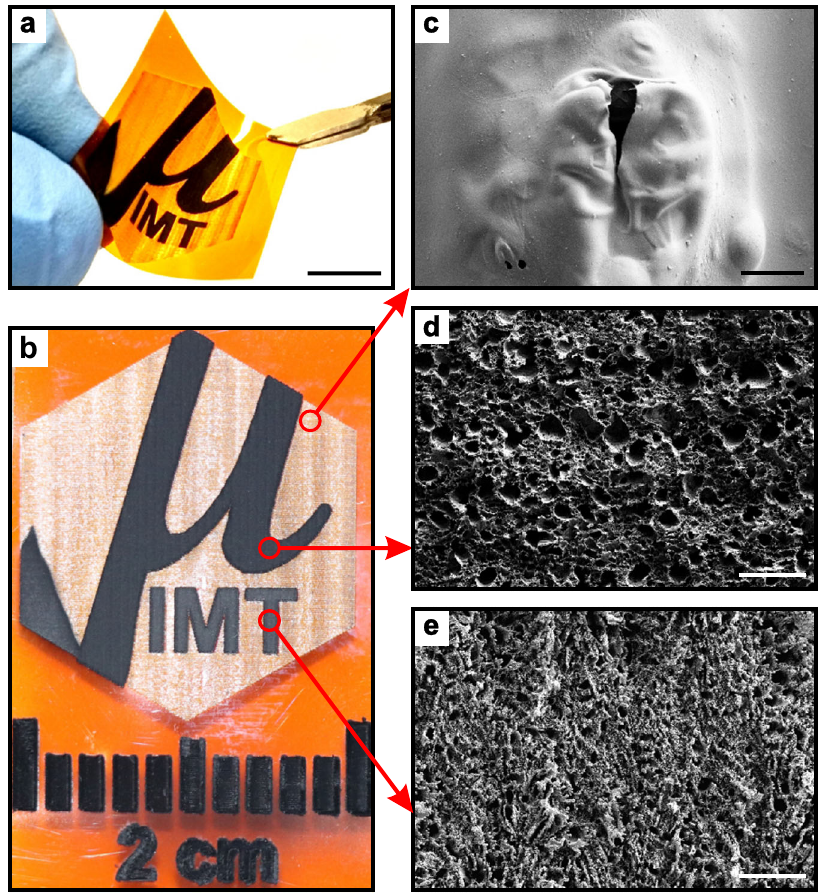
Fig. 2 a Photograph of a bendable laser carbon test structure on Kapton (scale bar: 1 cm). b Optical micrograph of a laser carbon sample showing three different regions. SEM micrographs of: ( c ) bleached Kapton surface at fl uence below carbonization threshold; and carbon surface produced by laser radiation ( d ) in air and ( e ) in nitrogen environment. Scale bar in c : 15 μ m; d and e : 50 μ